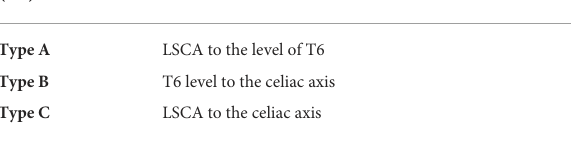
TABLE 2 Classification of TEVAR based on the extent of coverage of the descending thoracic aorta. TEVAR